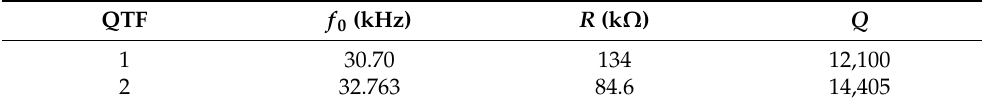
Table 1. The measured properties of the two QTFs in atmospheric